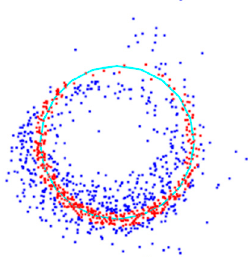
Figure 7. A 1.2–1.4 m interval point cloud of tree number 14 was projected onto a two-dimensional plane. Red points are considered to be inliers, while blue points are outliers, the proportion is 57.2%, and the fitted circle is cyan.